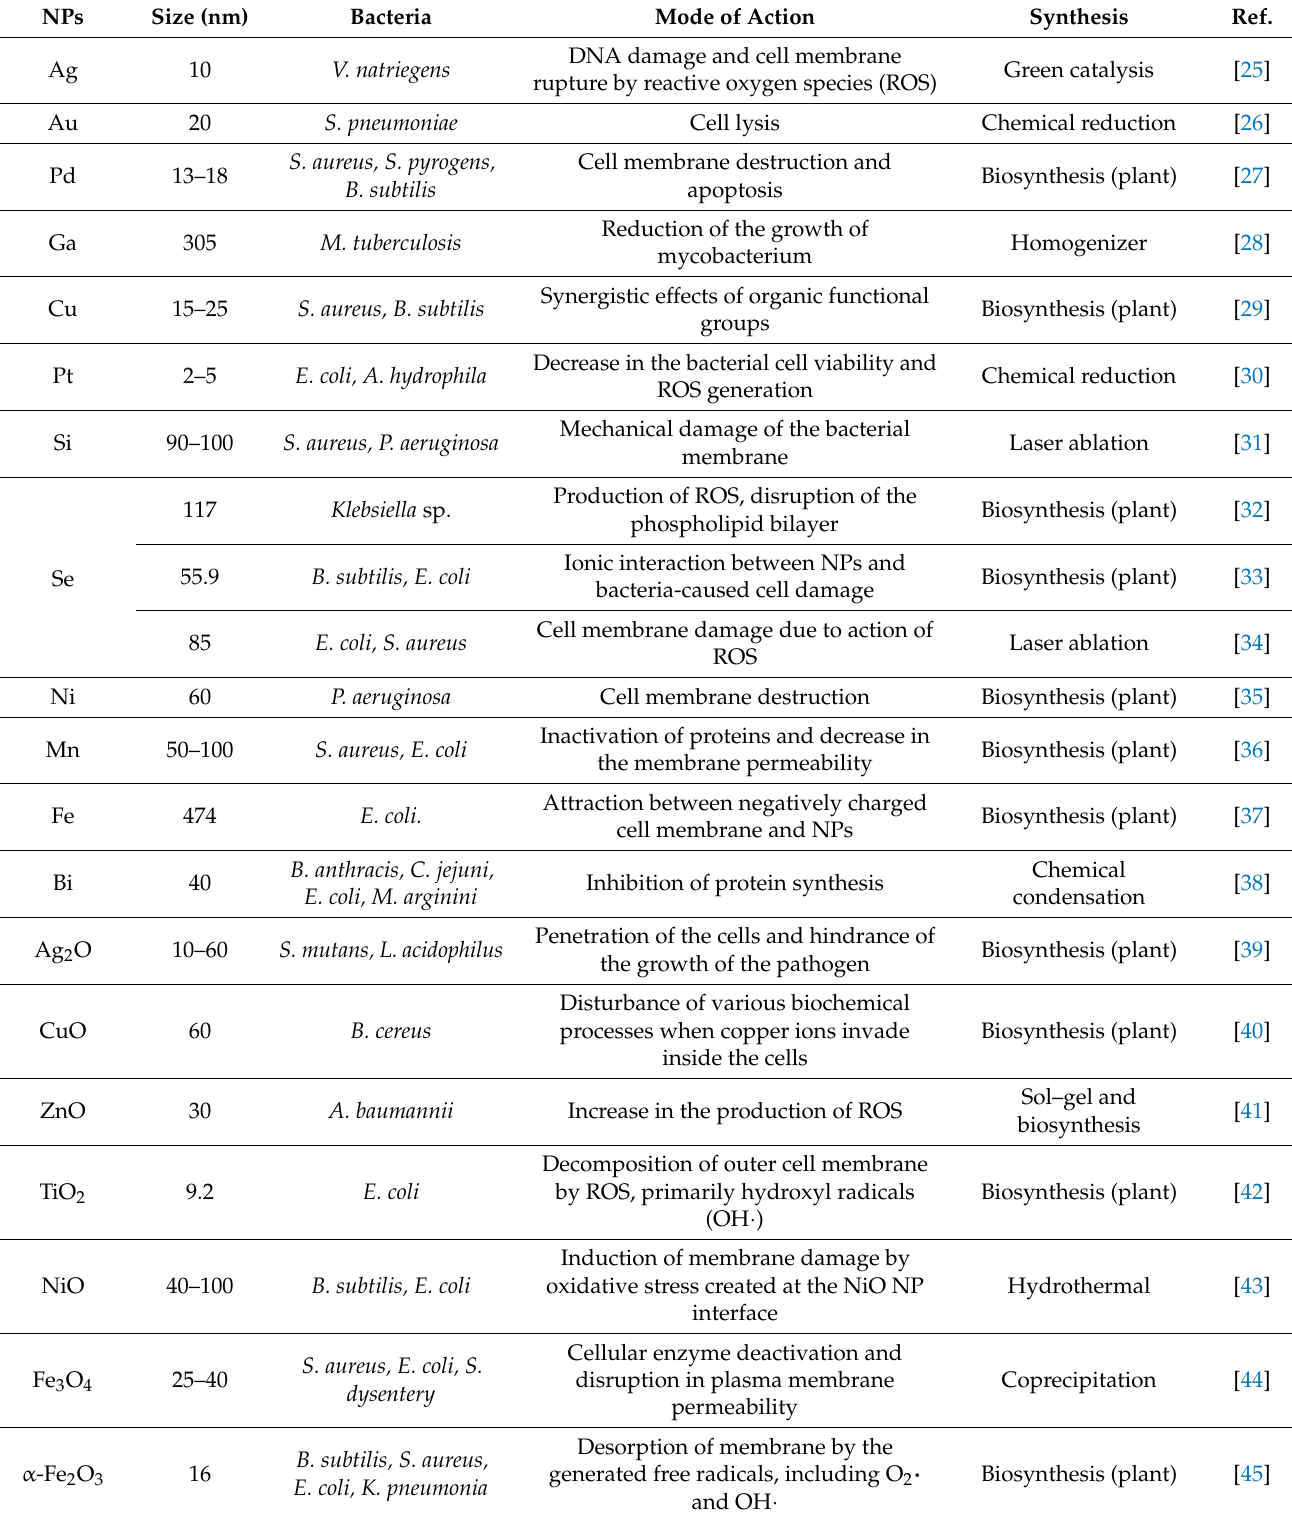
Table 1. Antimicrobial activity of monometallic and metal oxide nanoparticles